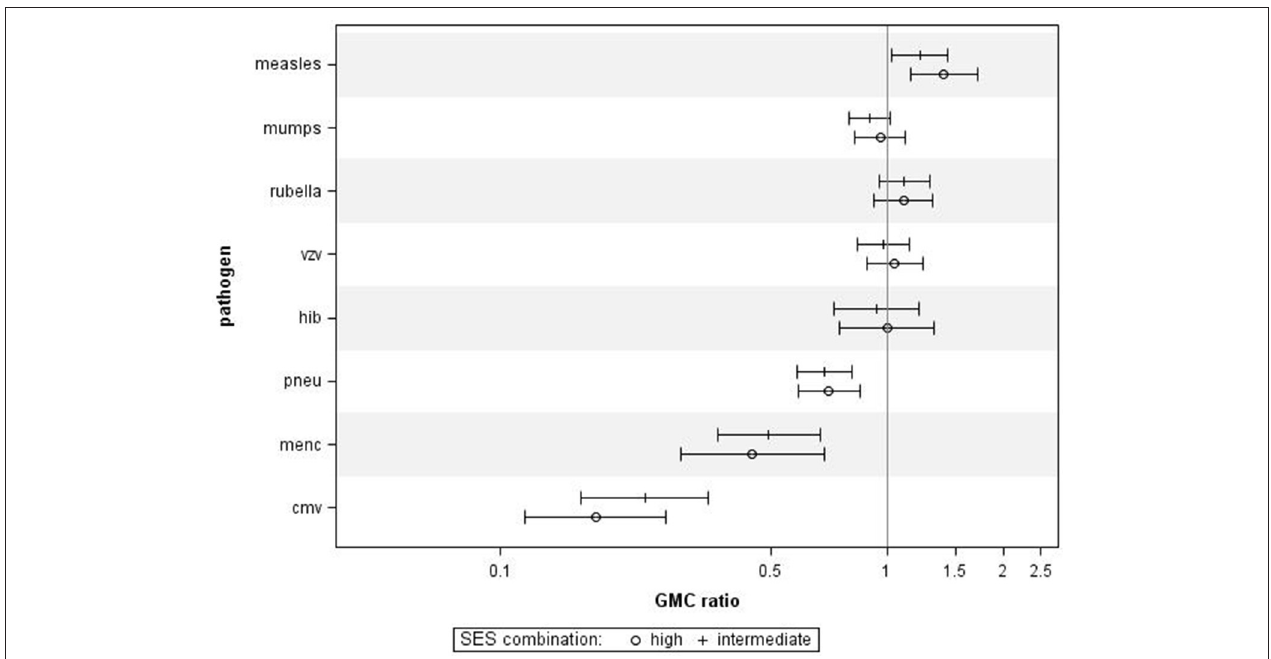
FIGURE 3 | Crude geometric mean concentration ratios per pathogen of socioeconomic status (SES) combined. High and intermediate SES compared to low SES with corresponding 95% C.I. N = 1,256.